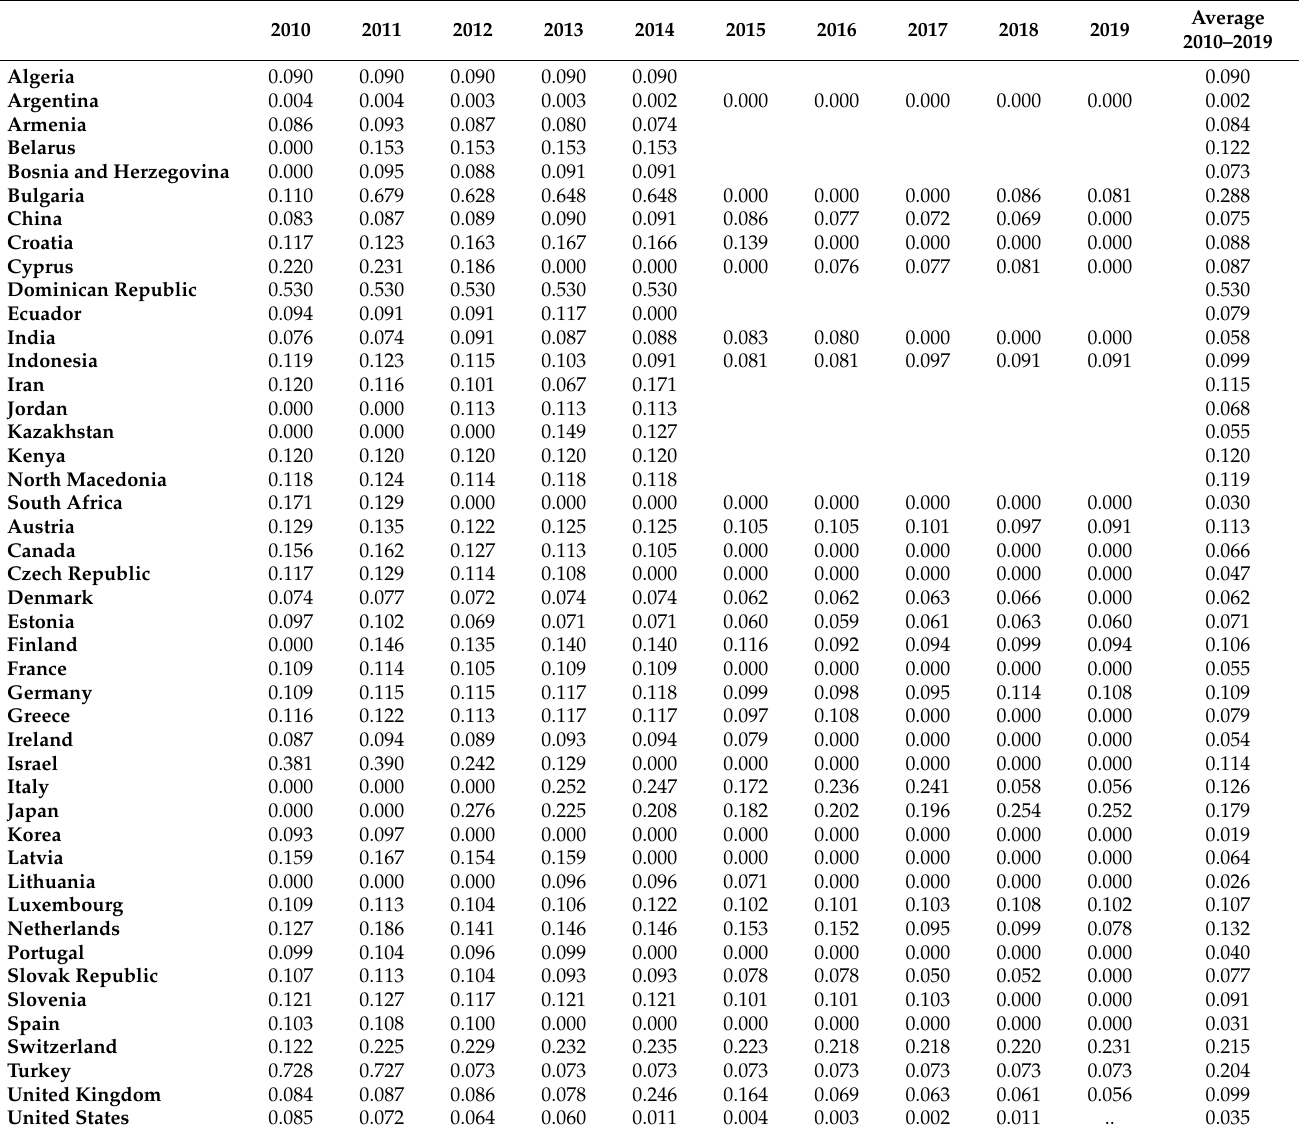
Table A2. Wind FiT